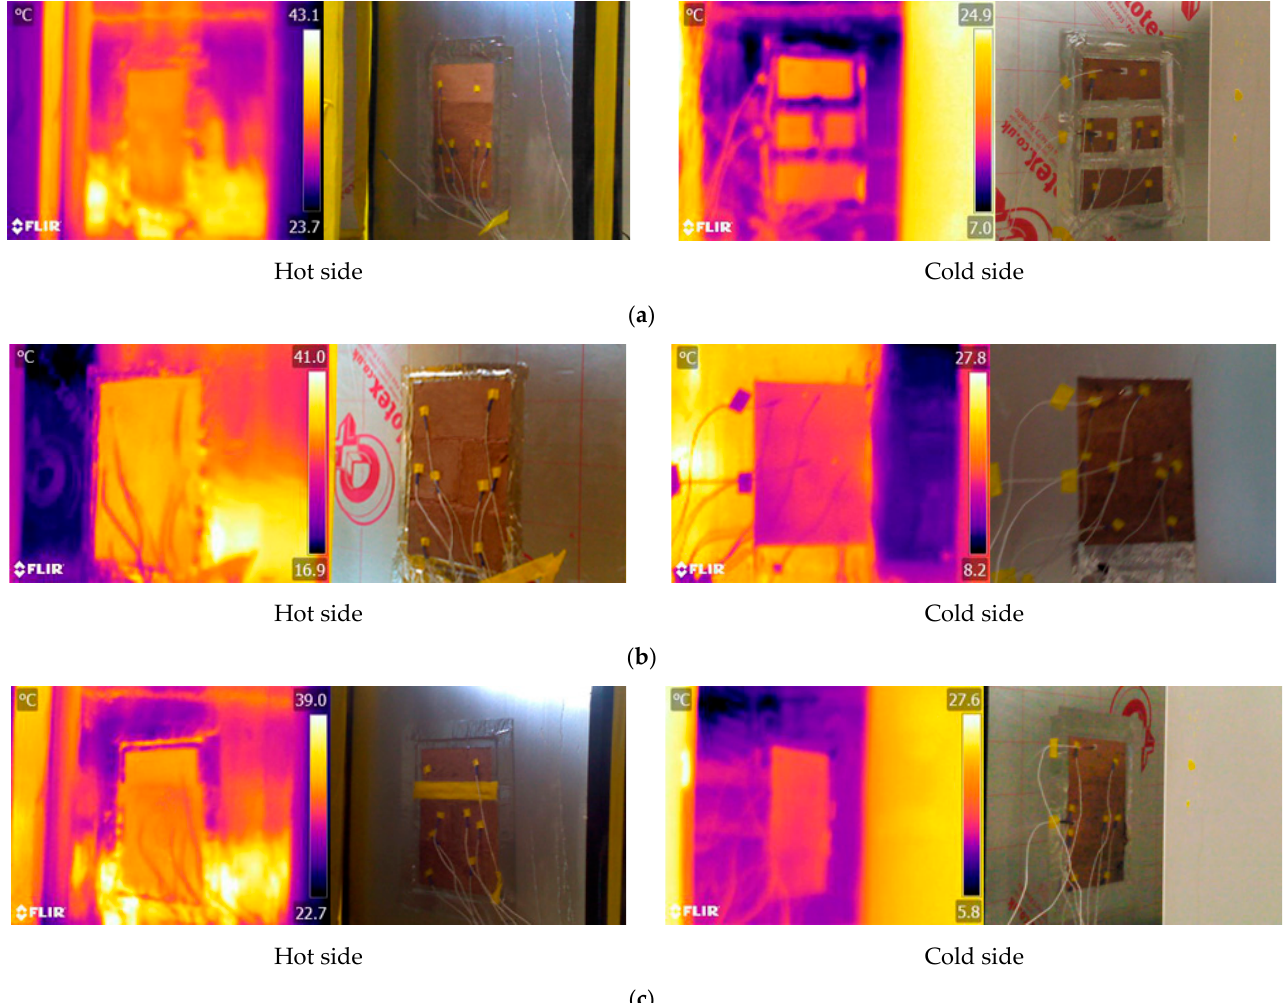
Figure 9. Thermographs of different wall surfaces: ( a ) reference wall; ( b ) sawdust wall; ( c ) coconut coir dust wall.